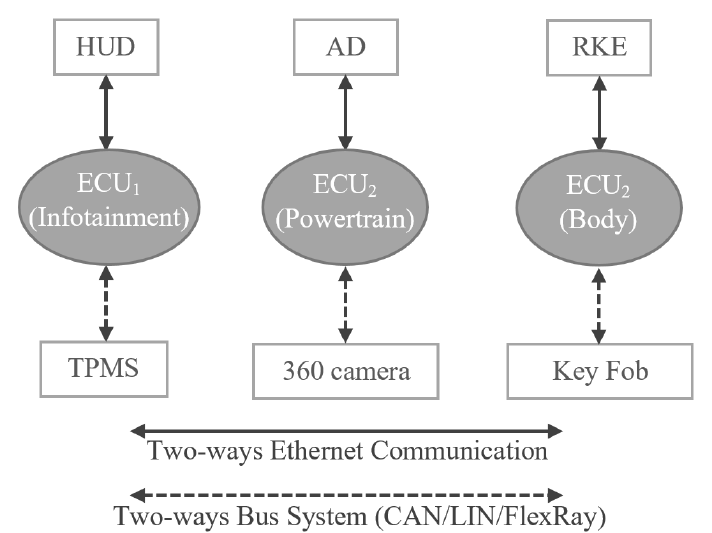
Figure 5. Use Case Representation of Traditional Architecture.